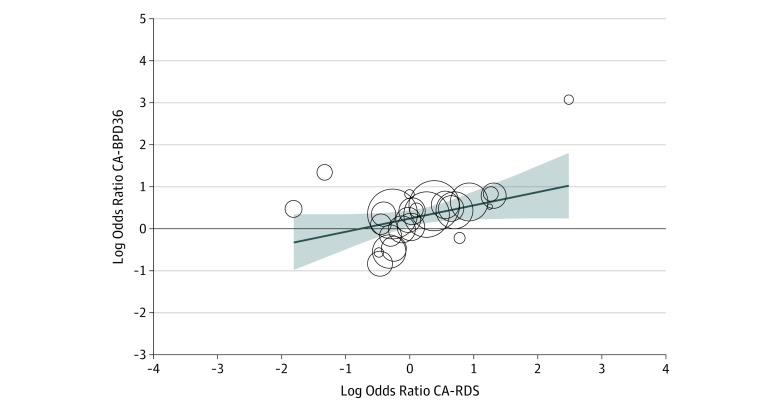
Multivariate Metaregression Analysis of Chorioamnionitis (CA) and Bronchopulmonary Dysplasia (BPD) and CA and Respiratory Distress SyndromeMultivariate regression model with backward elimination, controlling for difference in gestational age between CA-exposed and CA-unexposed infants. A total of 27 studies were included (coefficient, 0.31; 95% CI, 0.09-0.54; P = .007; R2 equivalent, 0.64). BPD36 indicates BPD with supplemental oxygen requirement at the postmenstrual age of 36 weeks.